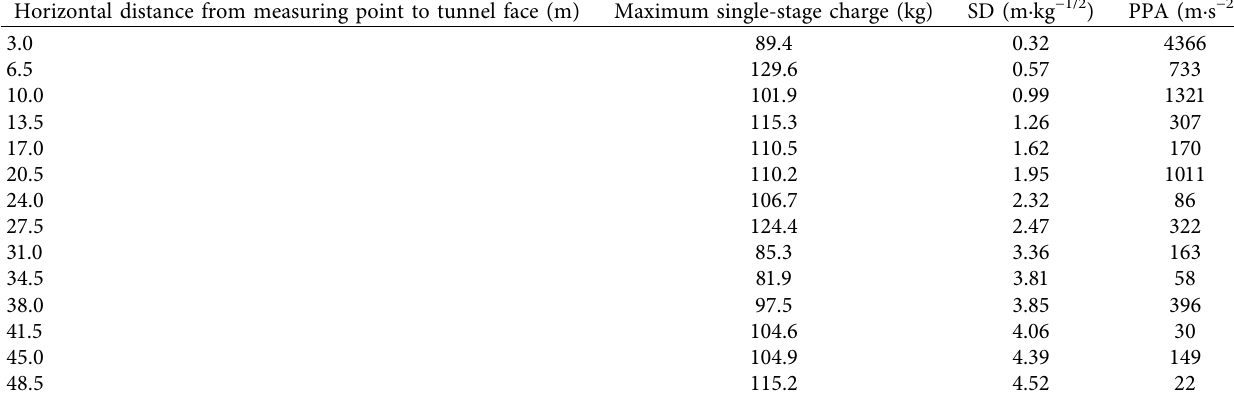
Table 3: Partial vibration acceleration data. Horizontal distance from measuring point to tunnel face (m) Maximum single-stage charge (kg)